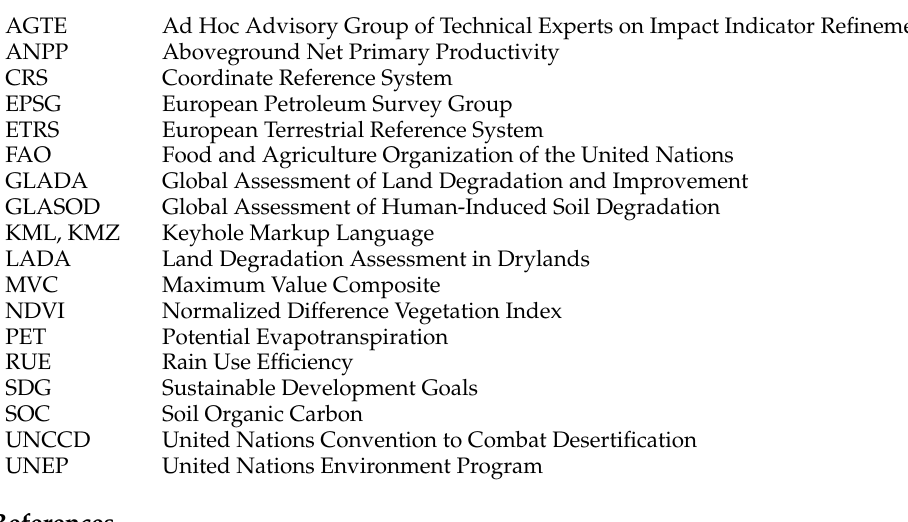
Table S1: Parameters of the boundary functions fitted to the 1st and 99th percentiles of the observed